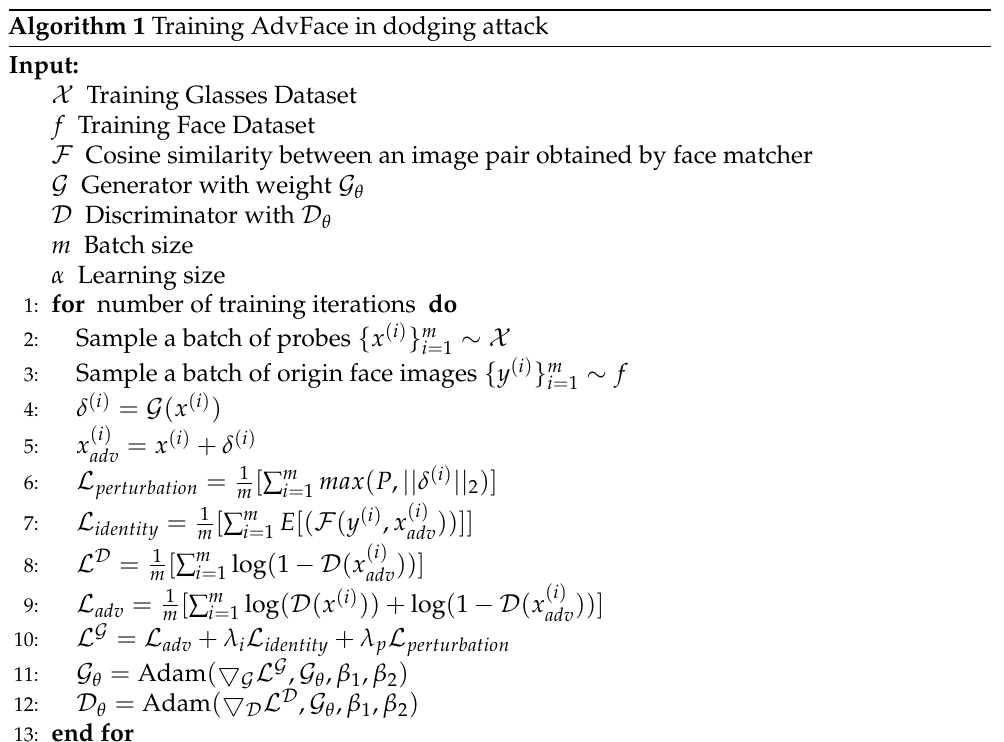
Figure 1. Proposed